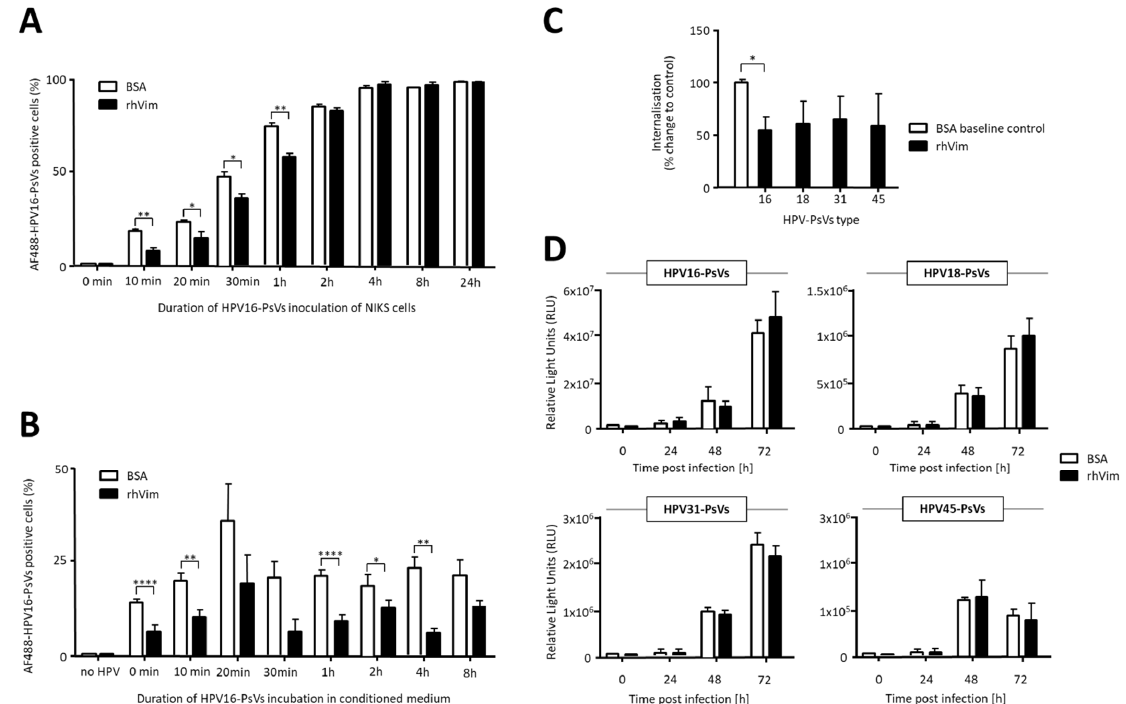
Figure 2. Pre-incubation of HPV16-PsVs with rhVim shows transient effects on viral internalisation. ( A ) AF488-conjugated HPV16-PsVs pre-incubated with rhVim or BSA control at a 1:1 ( w / w ) ratio at room temperature for 1 h were added to NIKS cells for the indicated time points, which were then processed for quantification of viral internalisation by flow cytometry. ( B ) AF488-conjugated HPV16-PsVs were pre-incubated with rhVim or BSA control at a 1:1 ( w / w ) ratio at room temperature for 1h and then added to pre-warmed NIKS conditioned medium at 37 °C for the indicated time points before addition to NIKS cells for 30 min. Thereafter, cells were processed for quantification of viral internalisation by flow cy- tometry. ( C ) AF488-conjugated HPV-PsVs of the indicated types were pre-incubated with rhVim or BSA control at a 1:1 ( w / w ) ratio at room temperature for 1 h and then added to NIKS cells for 30 min to assess internalisation by flow cytometry. ( D ) HPV-PsVs of the indicated types were pre-incubated with rhVim or BSA control at a 1:1 ( w / w ) ratio at room tempera- ture for 1 h and then added to NIKS cells for up to 72 h. Gaussia reporter gene activity as a measure for infection was assessed in the cell culture supernatant 24 h, 48 h and 72 h after addition of the virions to the cells. All experiments were quantified by quadrant analysis of the dot plots ( A – C ) or relative light units ( D ), respectively, and presented as % of the total cell population ( A , B ) or % change relative to cells infected with HPV/BSA control which was set as 100% ( C ). Com- binatorial analyses of three independent experiments are presented. Significance was calculated by means of two-way ANOVA and Tukey post hoc tests. Only statistically significant differences are indicated. * p < 0.05, ** p < 0.01, **** p < 0.001.